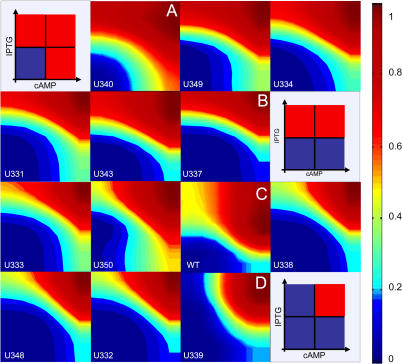
Input Functions of
lac CRR Variants
The input functions are ordered from top left to bottom right to range from those that most resemble OR gates to those that most resemble AND gates. (A) The most OR-like input function. (B) Input function resembles a single-input switch that responds only to IPTG and not to cAMP (note the elevated plateau III compared to the wild-type). (C) Wild-type input function. (D) The most AND-like input function, whose main difference from wild type is a lower plateau III.